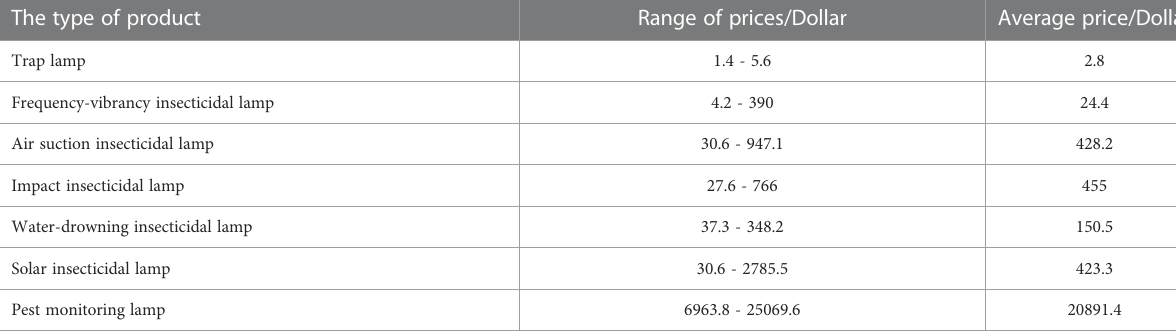
TABLE 2 Price range of different